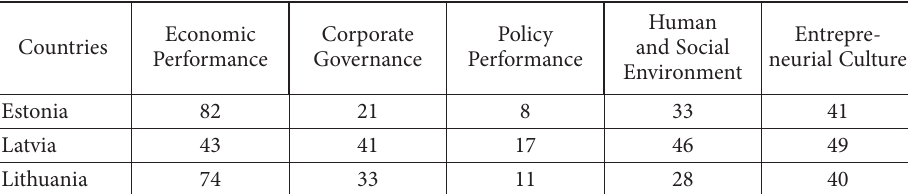
Table 2. The ranking of the Economic Performance, Corporate Governance, Policy, Human and Social Environmental and Entrepreneurial Culture of the Baltic States according to the VCPECA Index in 2018 (Groh et al.,